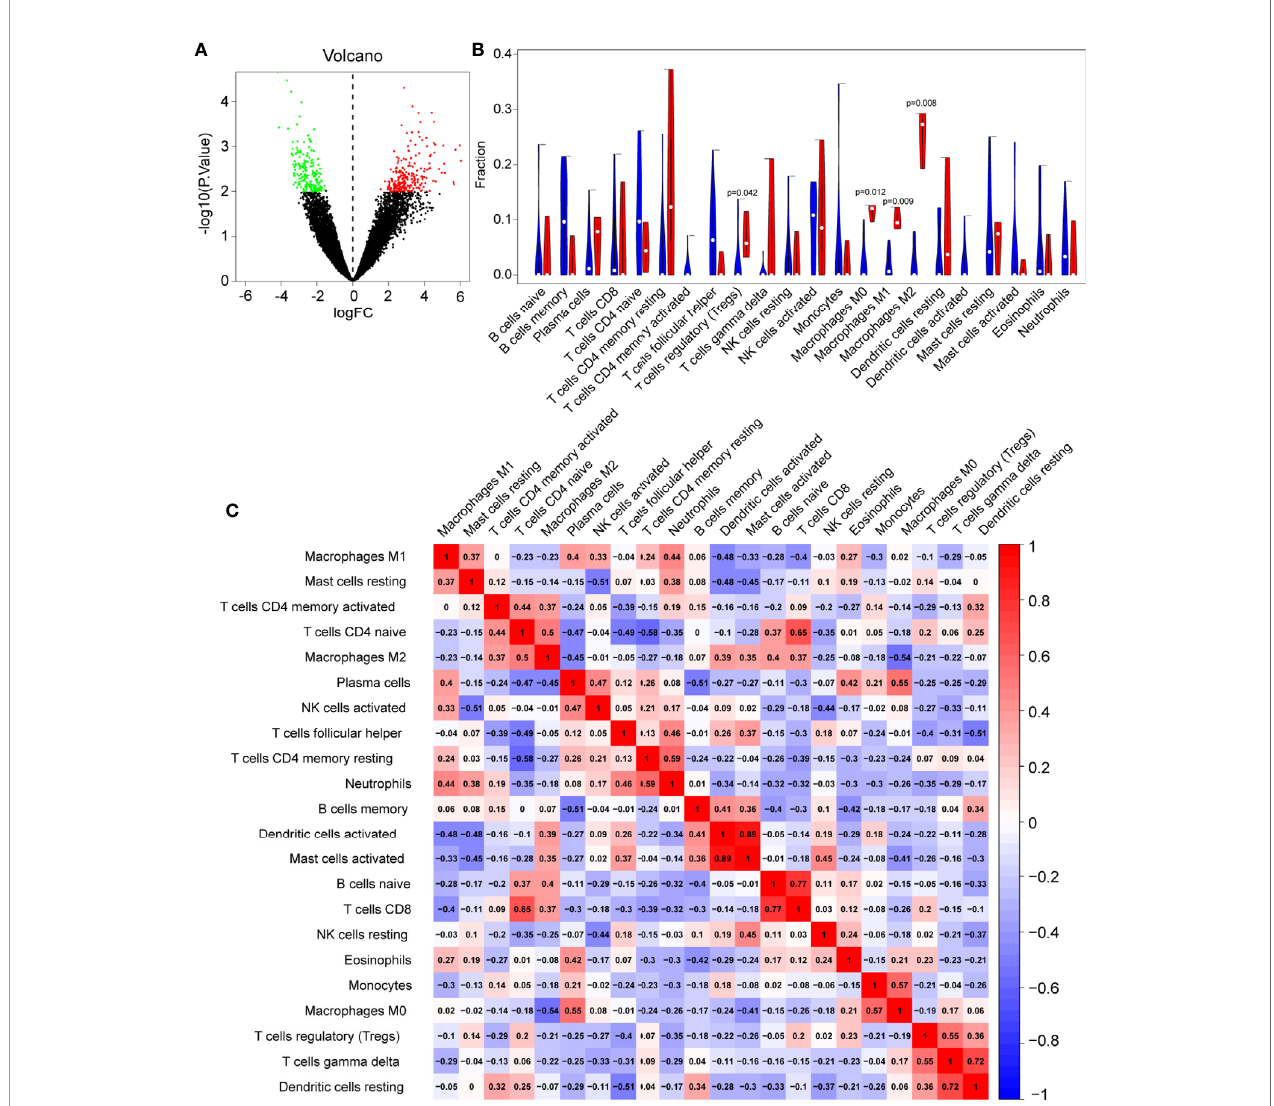
FIGURE 2 | The differentially expressed genes (DEGs) and immune in fi ltration landscape in nucleus pulposus (NP) tissue. (A) Volcano map of DEGs, where red represents upregulated genes and green represents downregulated genes. (B) Immune in fi ltration differences between intervertebral disc grade IV degenerative tissue and control tissue. (C) Correlation matrix of 22 immune cell type